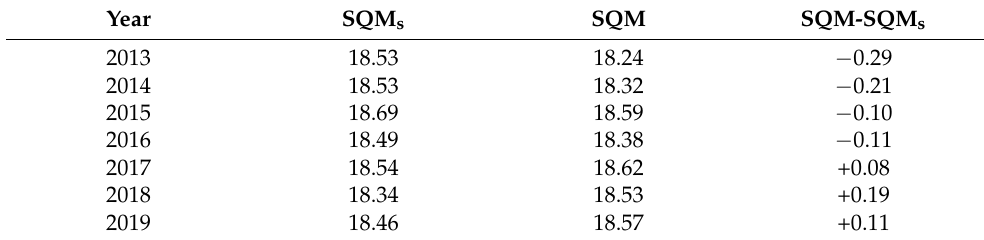
Table 2. Comparison SQM and synthetic SQM (mag/arcsec 2